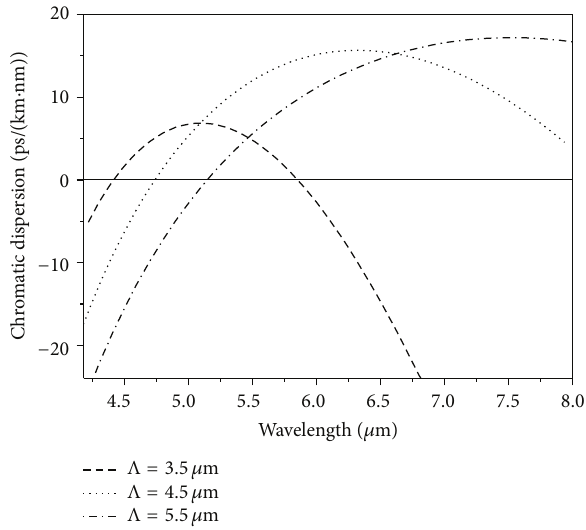
Figure 1: Chromatic dispersion for hexagonal PCFs with pitches of 3.5 𝜇 m (dashed), 4.5 𝜇 m (dotted), and 5.5 𝜇 m (dashed dotted). Table 1: Table summarizing the optogeometrical properties of the Se -based PCF under investigation. three As 2 3